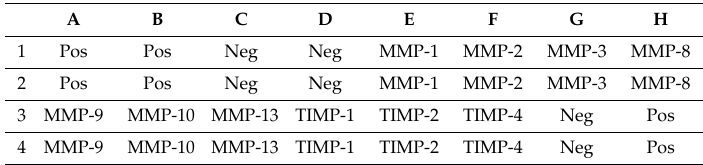
Table 1. MMP / TIMP Antibody Array